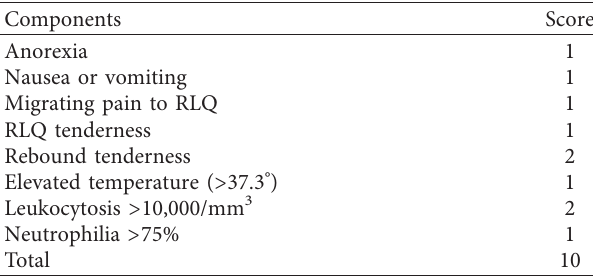
Table 1: Alvarado